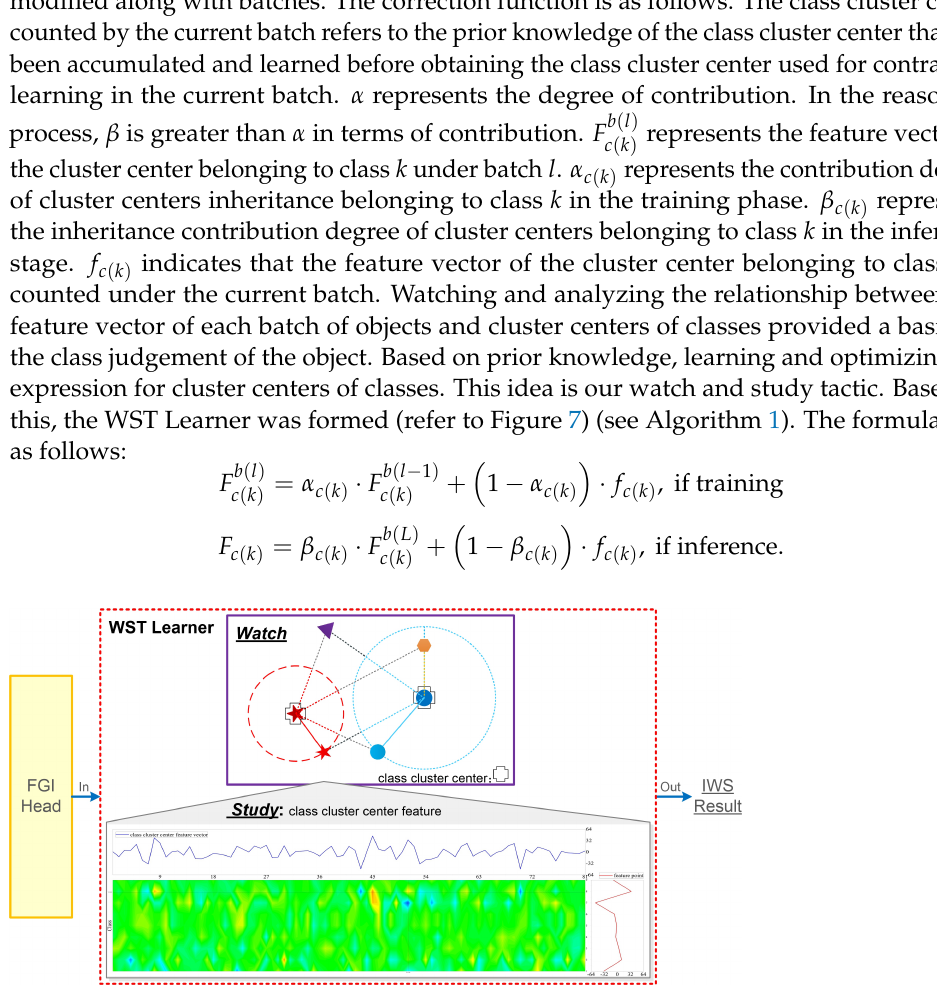
Figure 7. WST Learner calculation module. Algorithm 1 WST Learner in training